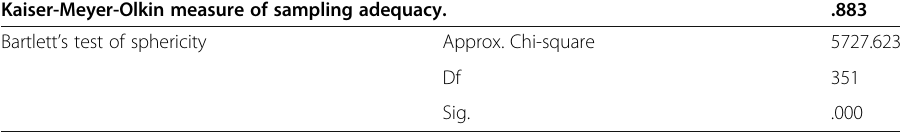
Table 2 KMO and Bartlett ’ s test Kaiser-Meyer-Olkin measure of sampling adequacy. .883 Bartlett ’ s test of sphericity